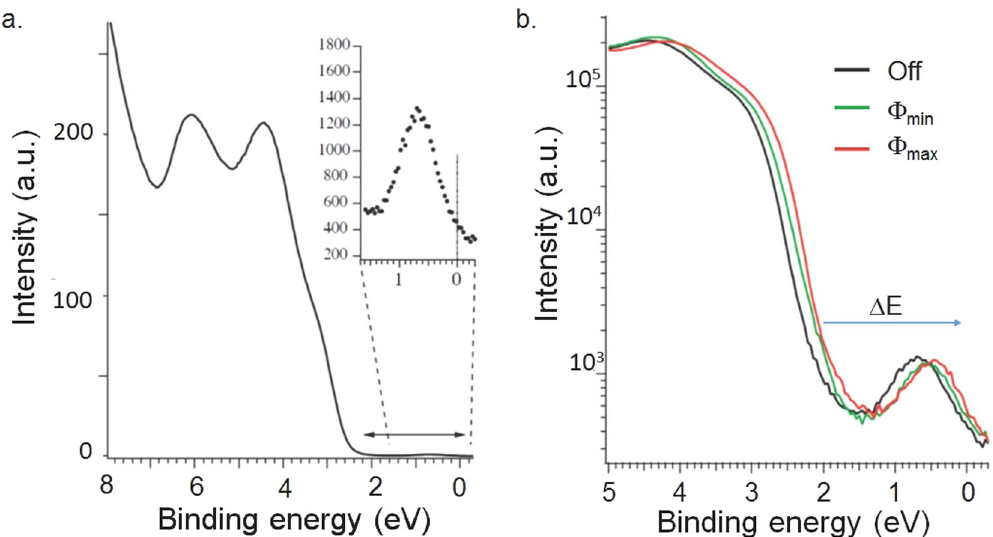
Figure 3. ( a ) Photoemission intensity as a function of binding energy obtained on in-situ cleaved CH 3 NH 3 PbBr 3 single crystal surface. Beyond the LUMO levels at high binding energies, one can read clearly the 2.2 eV band gap and a well-defined excitation close to the Fermi level; ( b ) The semi-log plot reproduces figure a (black line) and to spectra measured under 1.5 mW (green line) and 4.5 mW (red line) white light illuminations. The density of states at the Fermi level increases with the light